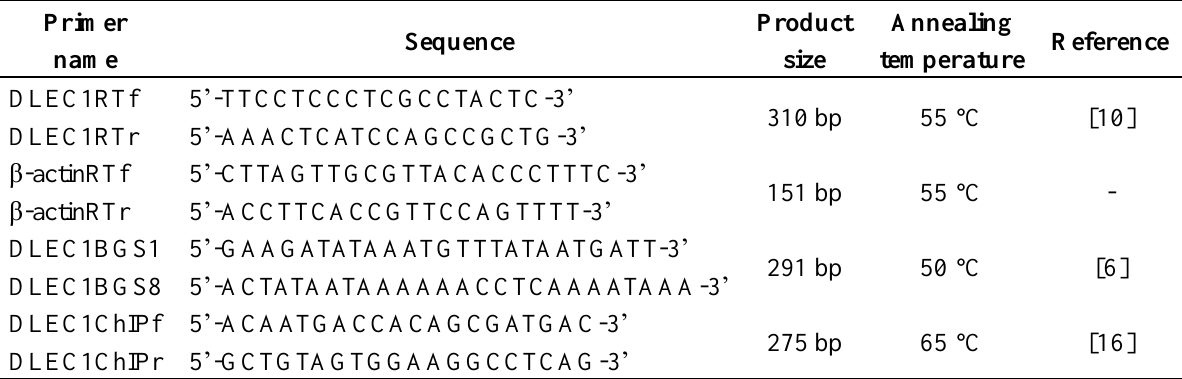
Table 1. Primers used for RT-PCR, BGS and